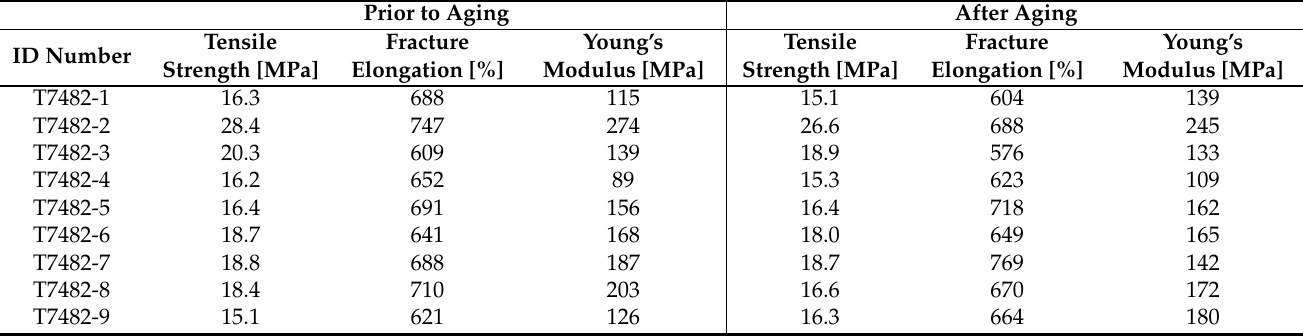
Table 5. Properties along the direction perpendicular to the production